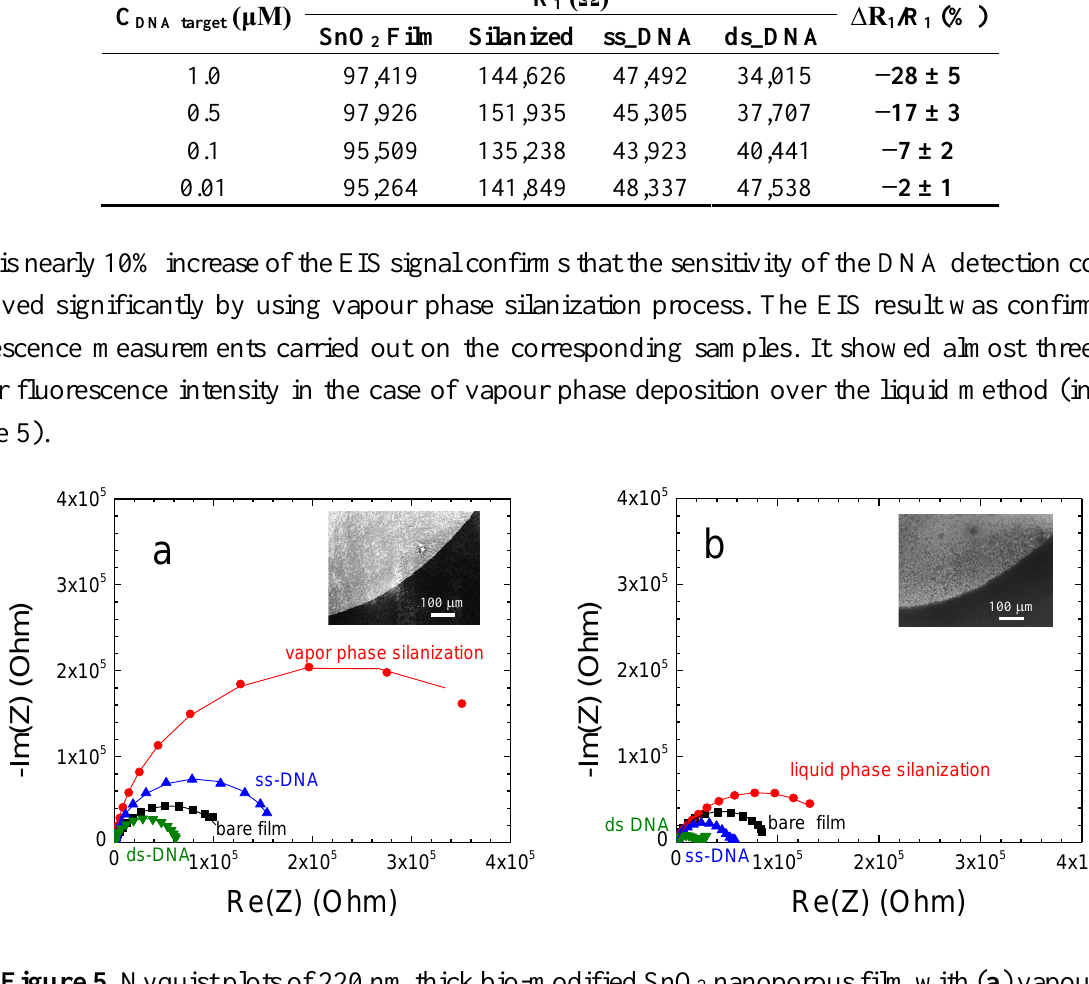
Figure 5. Nyquist plots of 220 nm thick bio-modified SnO 2 nanoporous film with ( a ) vapour phase and ( b ) liquid phase silanization processes. DNA complementary hybridization was performed with target concentration of 2 µM. The filled symbols correspond to experimental data and the continuous lines to fitting data. The inset shows the corresponding typical fluorescence micrograph after hybridization of complementary target labelled with